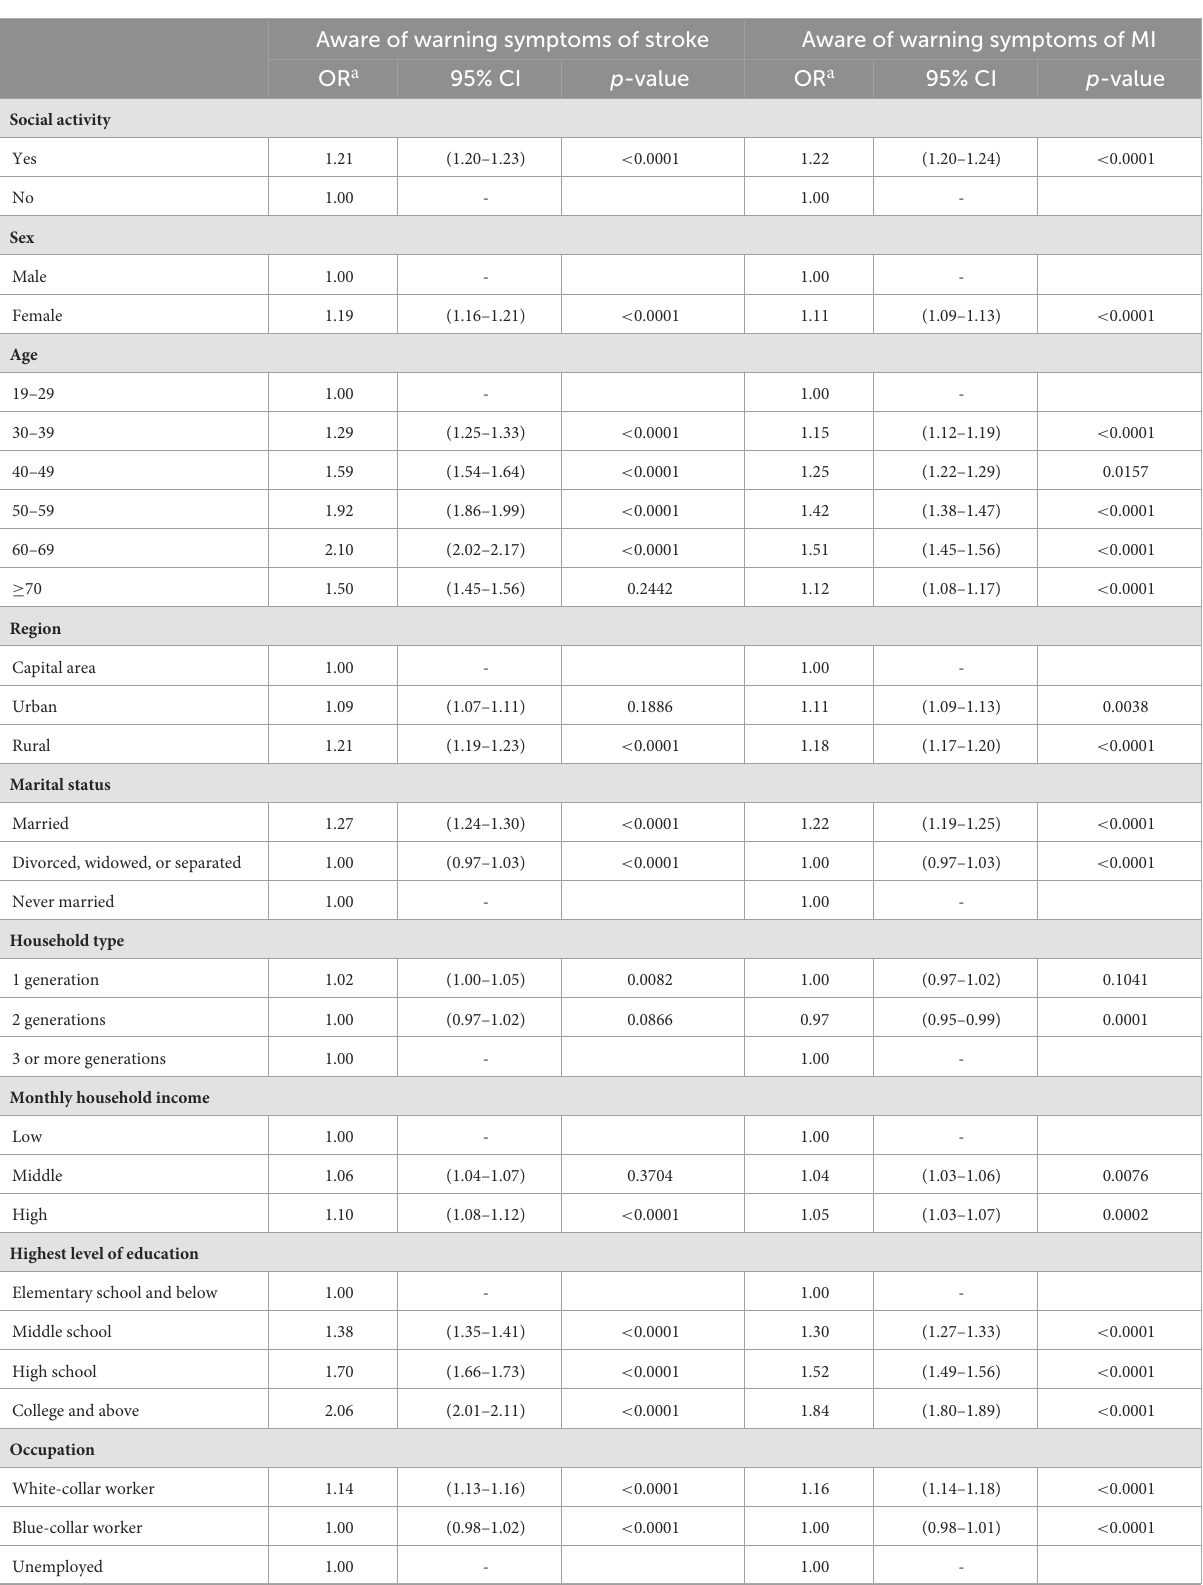
TABLE 2 Factors associated with awareness of warning symptoms of stroke and